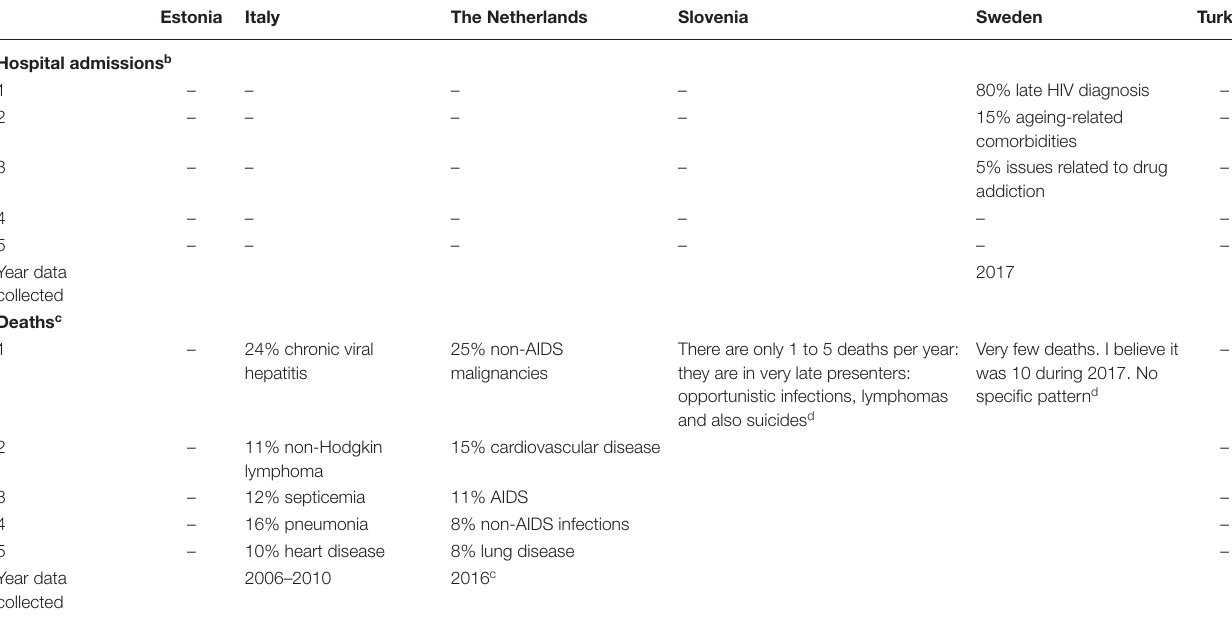
TABLE 4 | Leading causes of hospital admission and death among PLHIV in six European countries as reported by respondents a .